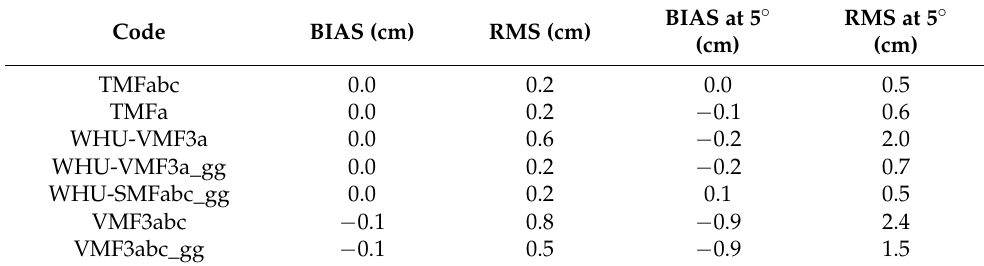
Table 6. Accuracy of MF-derived hydrostatic delays.